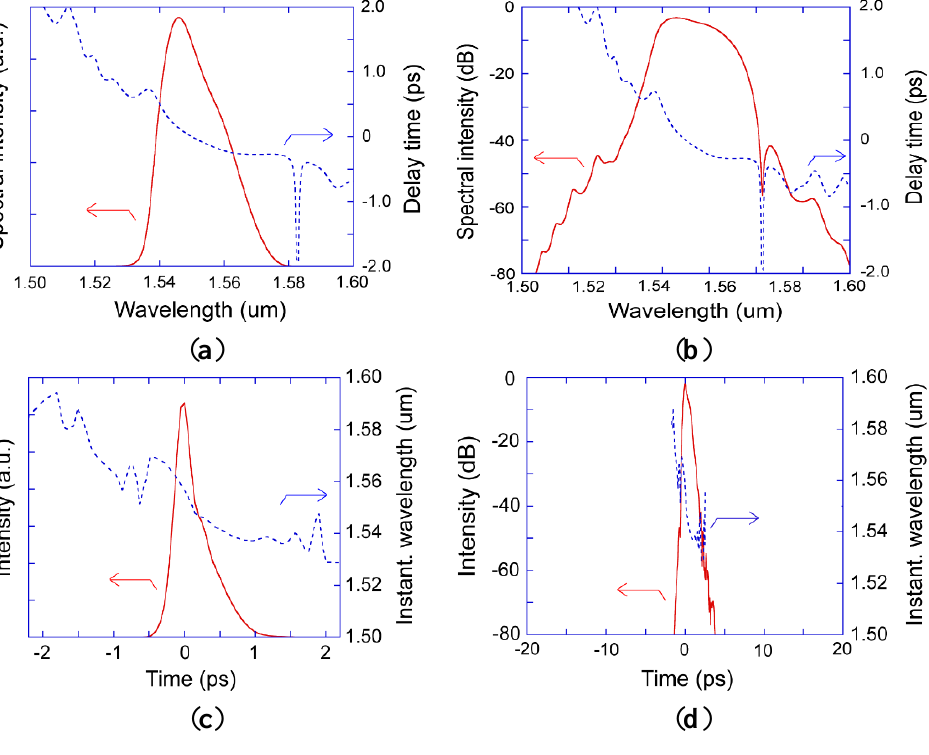
Figure 11. Characteristics of output pulse for stretched-pulse mode-locking regime. ( a , b ) Spectral shapes on linear and log scales. ( c , d ) Temporal shapes on linear and log scales. Variations of the spectral and temporal shapes of the output pulse for the initial mode-locking process are shown as movies in Media 5 and 6.